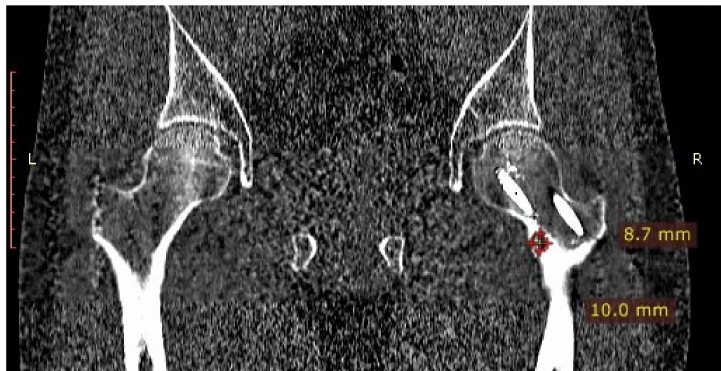
Figure 10. CT scan of the hip joints showing a focus of OO in the right femoral neck.